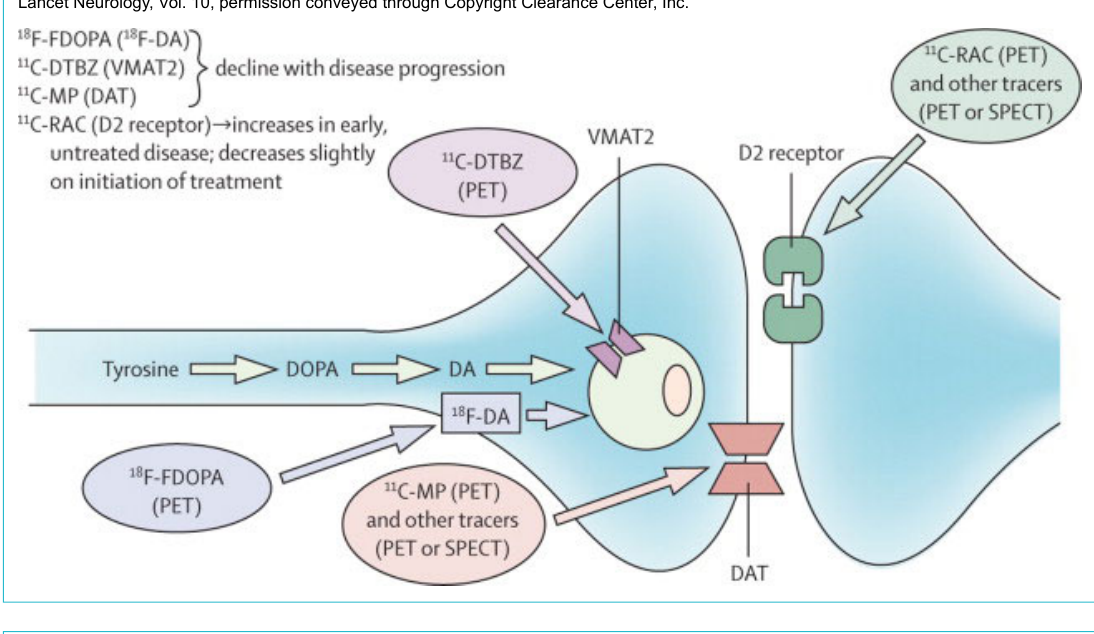
Figure 1: Summary of the dopaminergic pathways within the striatum and the main PET and SPECT targets.Republished with permission of Elsevier, from “Advances in imaging in Parkinson’s disease”, by A. Jon Stoessl, WR Wayne Martin, Martin J. McKeown, Vesna Sossi, The Lancet Neurology, Vol. 10, permission conveyed through Copyright Clearance Center, Inc.